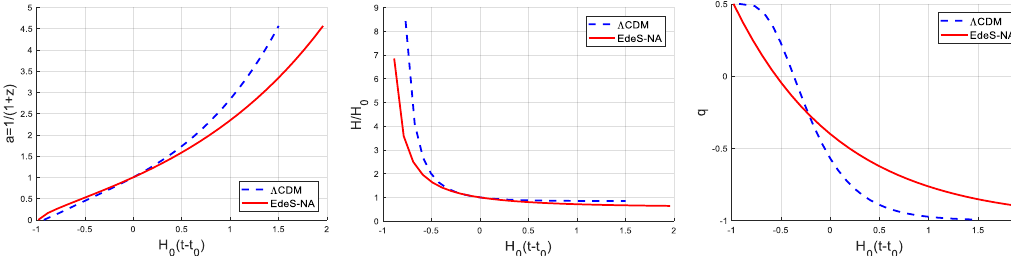
Figure 2. Evolution of dimensionless parameters: scale factor a ( left figure ), Hubble parameter H / H 0 ( middle figure ), and deceleration parameter q ( right figure ), against dimensionless time H 0 ( t − t 0 ) for the standard Λ CDM model and the nonadiabatic model EdeS-NA. Table 1. Parameter and goodness-of-fit for the two models. R 0 is in Mpc − 1 and H 0 is in km s − 1 Mpc − 1 . SSE stands for sum of squares due to errors and RMSE for root mean square